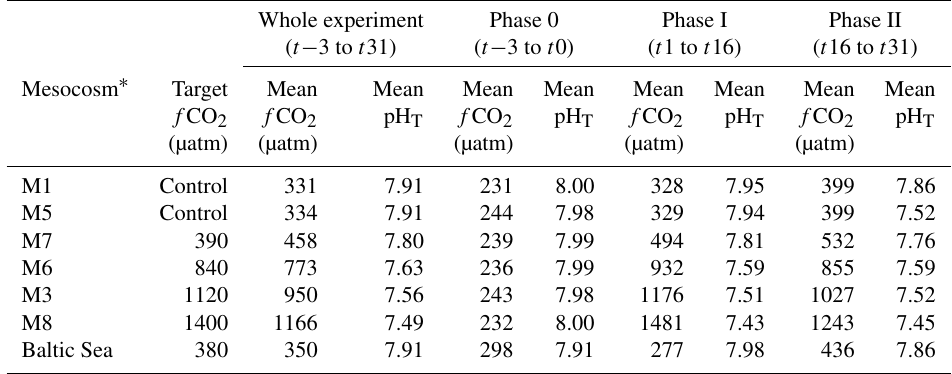
Table 1. Summary of f CO 2 and pH T (total scale) during phases 0, I, and II of the mesocosm experiment. Whole experiment Phase 0 Phase I Phase II ( t − 3 to t 31)